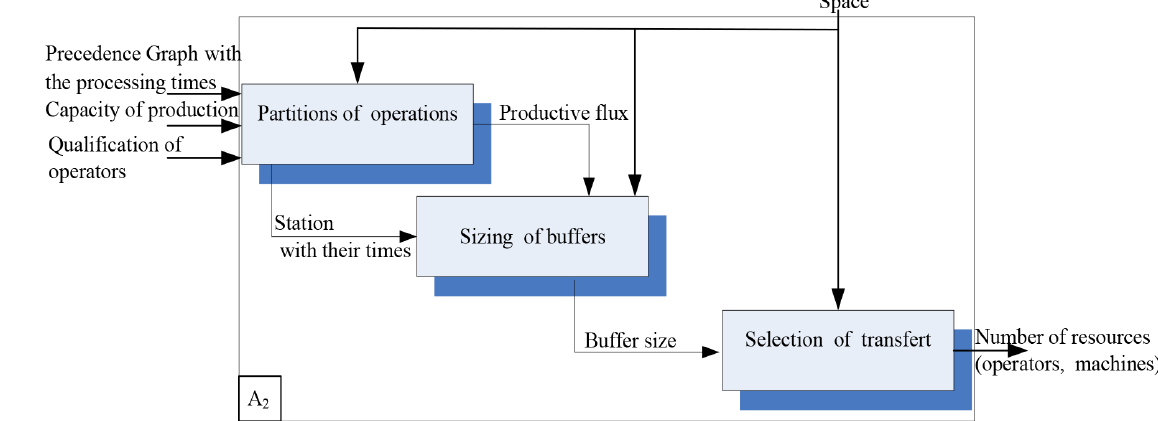
Figure 7. Activity A